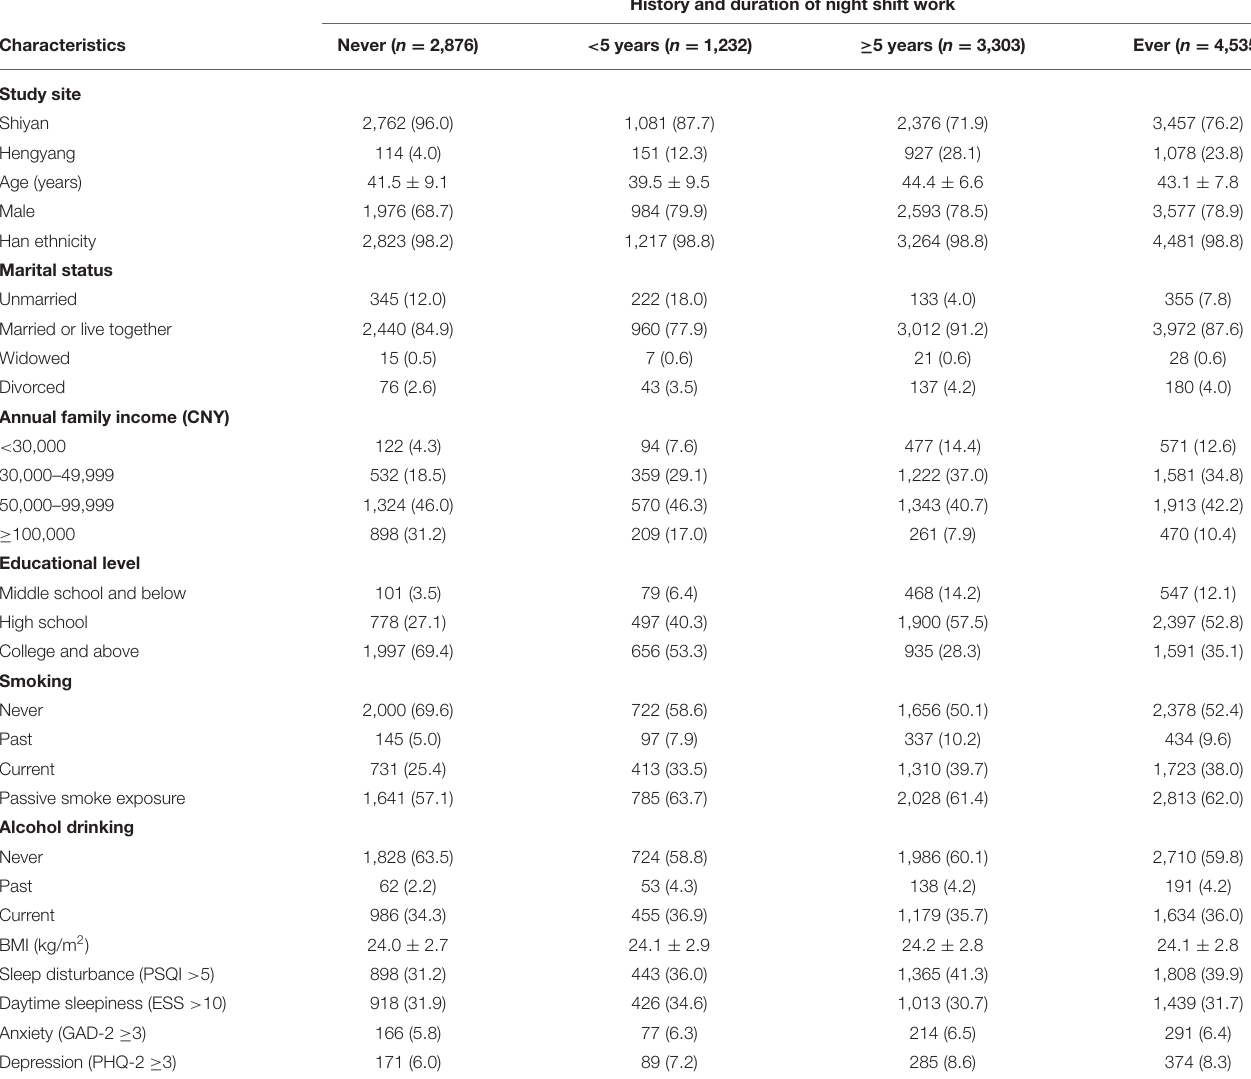
TABLE 1 | Characteristics of participant by the history and duration of night shift